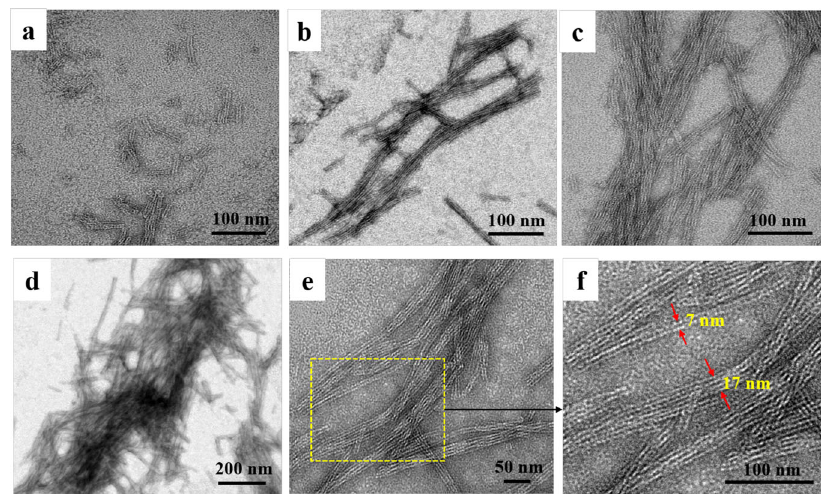
Fig. 2 Characterization of the fi laments constructed by 48.0 µ M FLAL and 80 mM Ca 2 + . a – d TEM images of the fi laments at different time points (0.5, 1, 12, and 24h). e High-magni fi cation transmission electron microscopic (HRTEM) images of the fi laments. f Real map of the inverted FFT of e